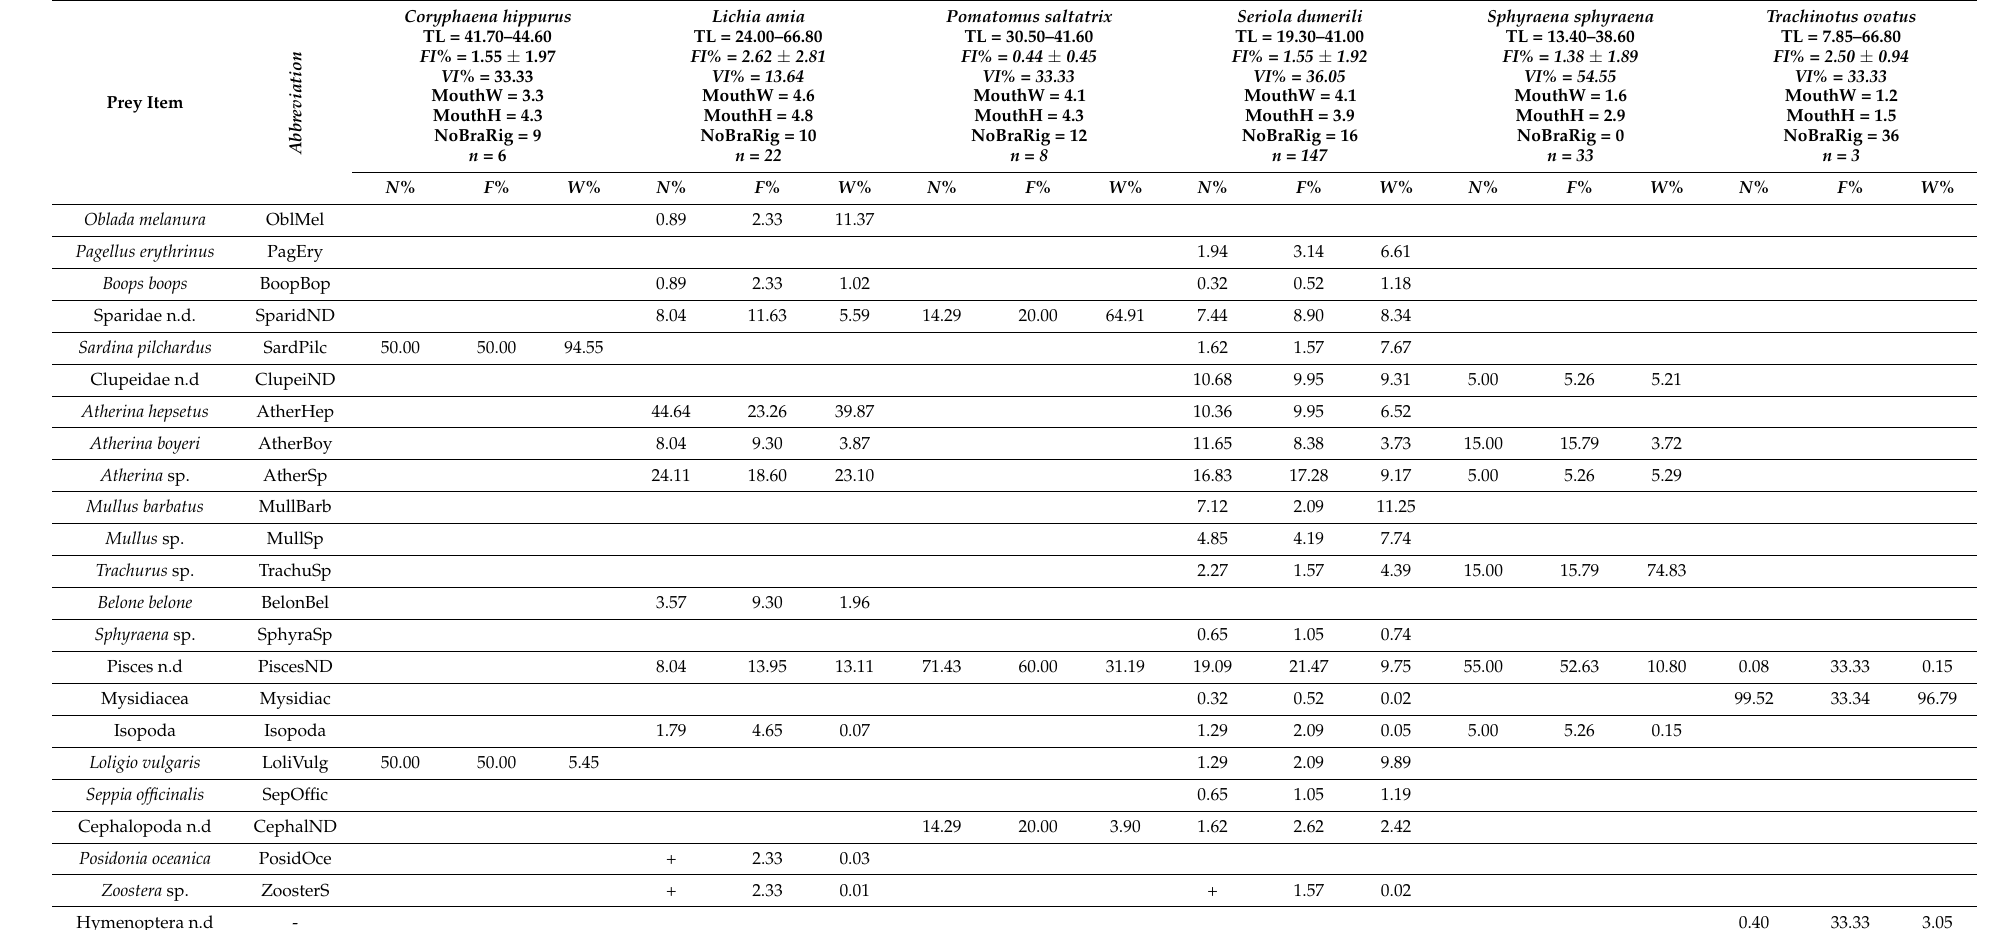
Table 1. Frequency of occurrence ( F %), numerical frequency ( N %), mass frequency ( W %), vacuity coefficient ( VI %) and fullness index ( FI %) ± standard deviation of the prey items consumed by six species caught in the Bay of Medulin (TL = size range as the total length in cm; n = number of analysed specimens; n.d—not determined; MouthW = average mouth width (cm); MouthH = average mouth height (cm); NoBraRig = mode of the number of rakers on the right gill